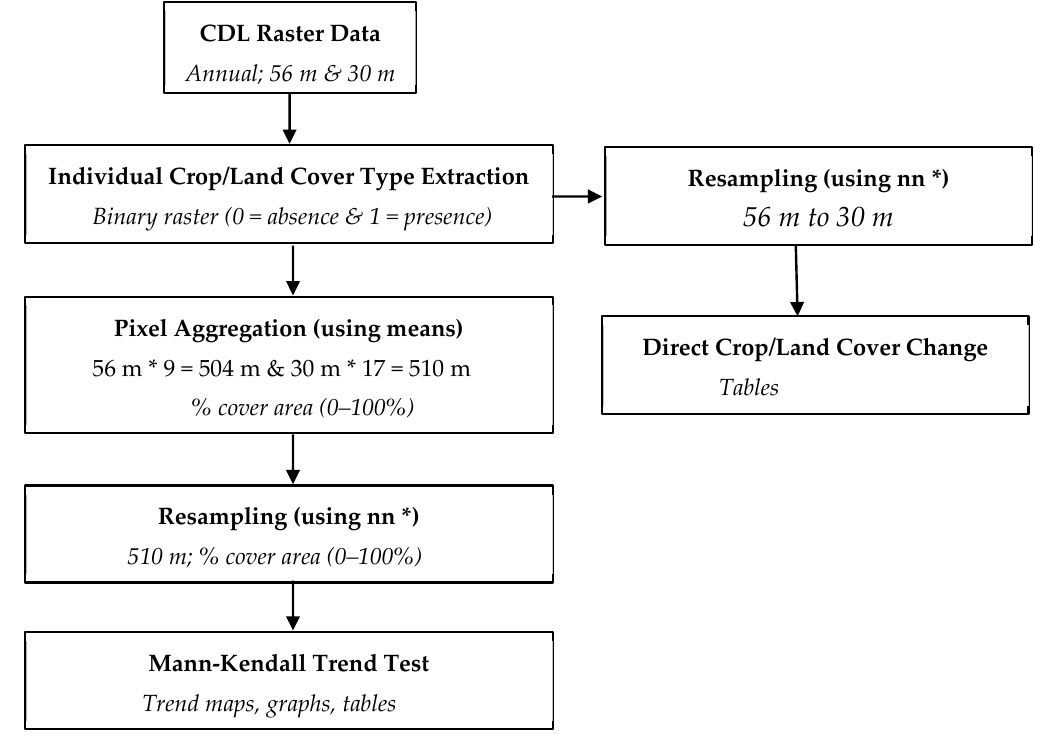
Figure 2. Flowchart for the trend analyses in the study. For the US–PPR, data from 2006–2018 was used, while for the ND PPR, we used two epochs (1998–2007 & 2008–2017). The CDL data have 56 m spatial resolution until 2008 and 30 m thereafter. * nn=nearest neighbor.